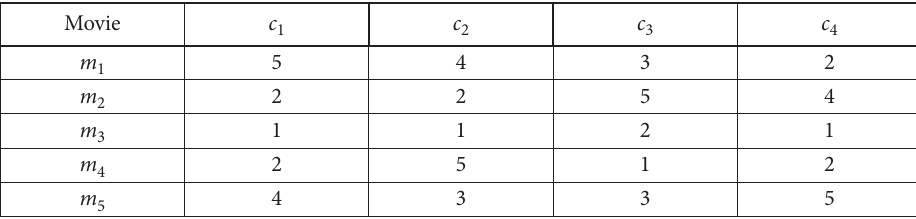
Table 4. Ranking alternatives based on score function